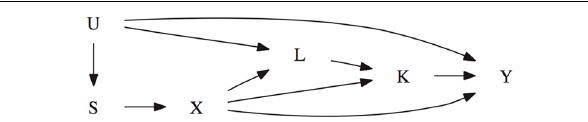
FIGURE 1 | Causal diagram illustrating the confounding of the target phenotype Y and the marker locus X . S denotes the parental genotype or Rabinowitz and Laird’s sufficient statistic. K denotes the secondary phenotype of interest. L allows for confounding between K and Y . U represents a collection of unmeasured factors that allow for confounding due to population stratification or confounding between the two phenotypes K and Y . Note that causal diagrams assume that all variables that jointly affect any two variables are included. The absence of an arrow between any two variable denotes that there is no direct causal effect. For instance, U has no direct causal effect on X